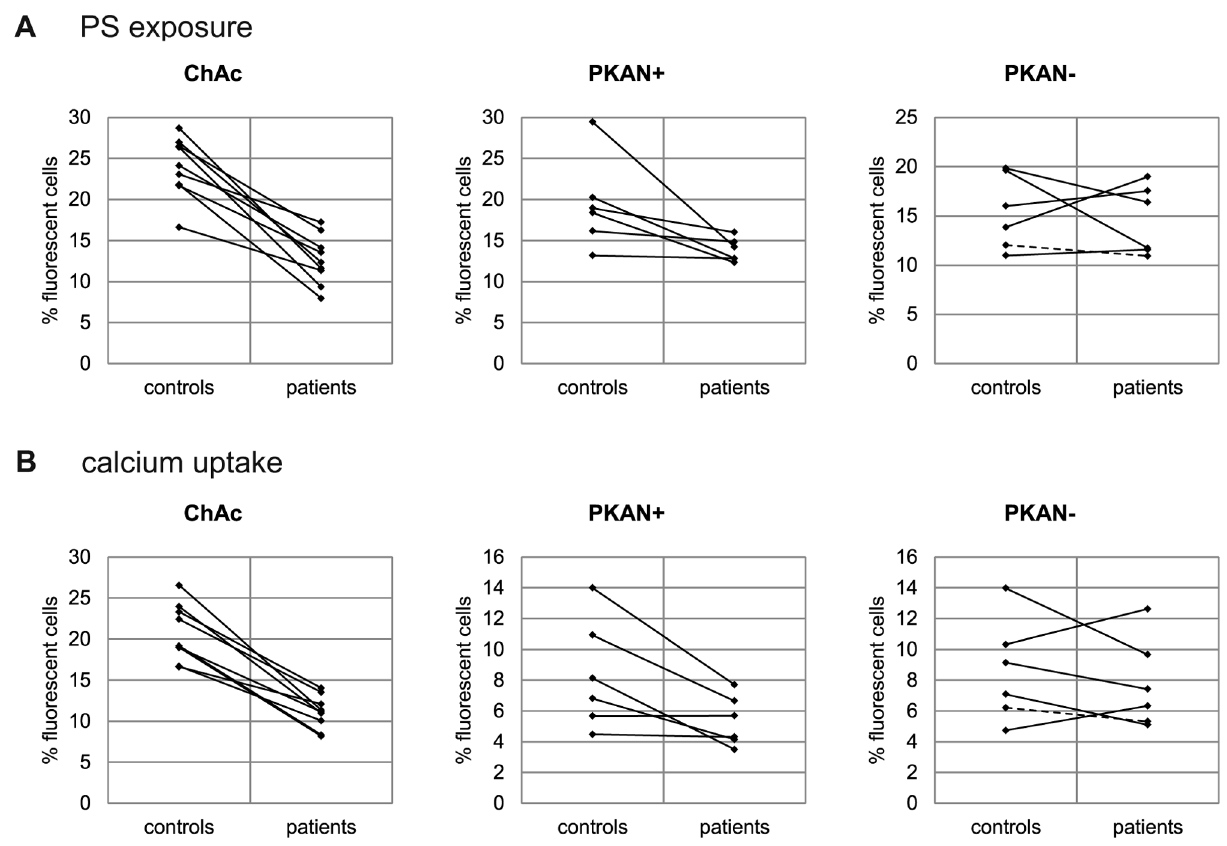
Figure 7. Altered LPA-induced PS exposure and calcium uptake in erythrocytes of patients with acanthocytes. Erythrocytes from patients and control donors were treated with LPA as described in Materials and Methods and either PS exposure (A) or calcium uptake (B) was monitored by flow cytometry. The percentage of FITC-annexin V-positive cells (A) and of Fluo-3-positive cells (B) of patient and control samples are shown and respective pairs are connected by lines. The data of the MPAN patient within the NBIA/PKAN- cohort is shown as a dashed